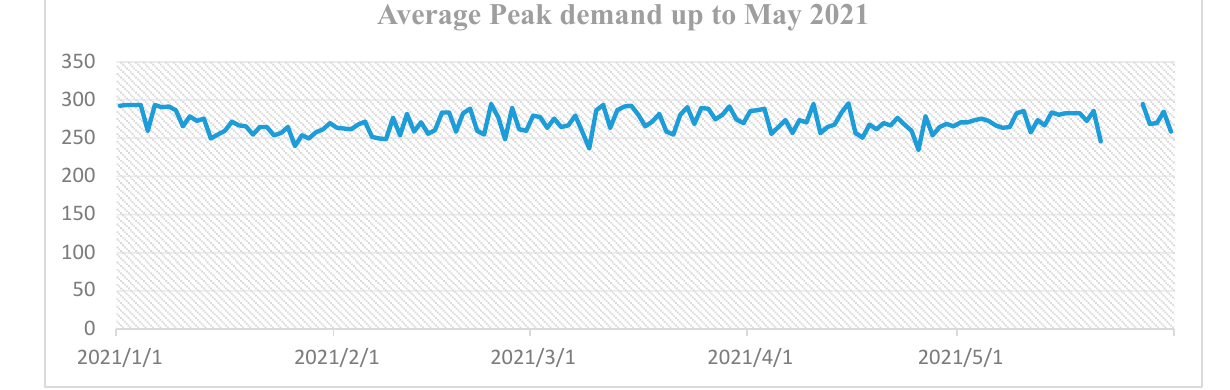
Figure 10. Simulated average peak demand for the year 2021.